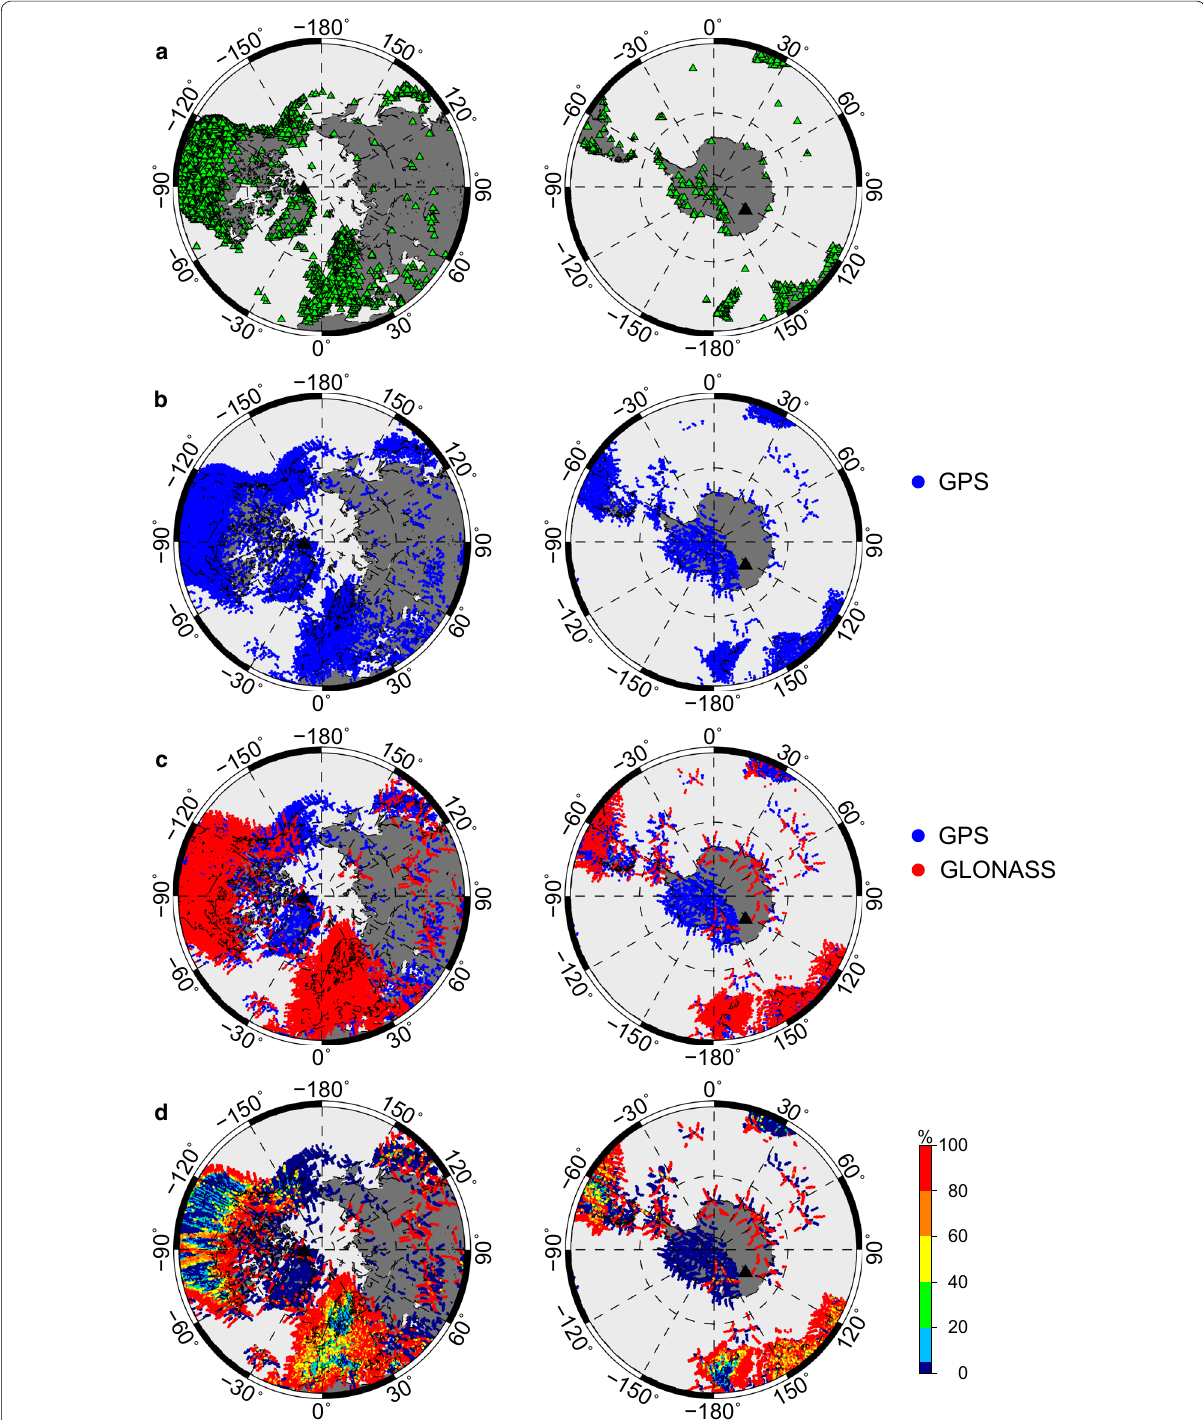
Fig. 2 Data coverage over the northern ( left ) and southern ( right ) hemispheres within geographic latitudes of 30°–90°: a distribution of GNSS stations; examples of the data coverage accumulated during 1 h by b GPS signals only and c combined GPS and GLONASS signals, d percentage contribution of GLONASS data in each cell. Black triangle indicates the location of the geomagnetic